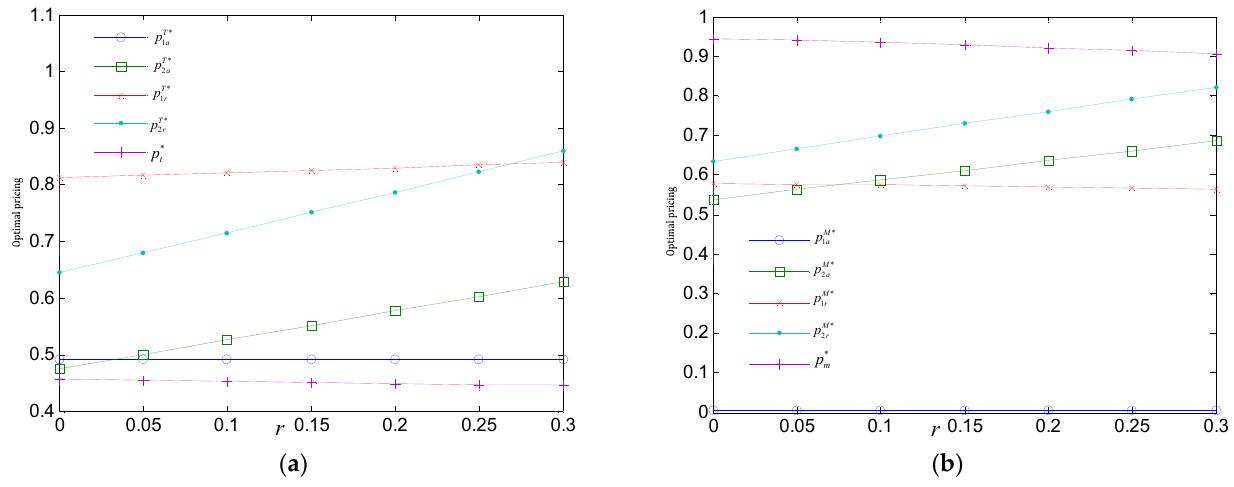
Figure 6. Impacts of improvement rate r on the pricing with two trade-in programs. ( a ) The impact of r on the pricing under ON model; ( b ) The impact of r on the pricing under VPN model.